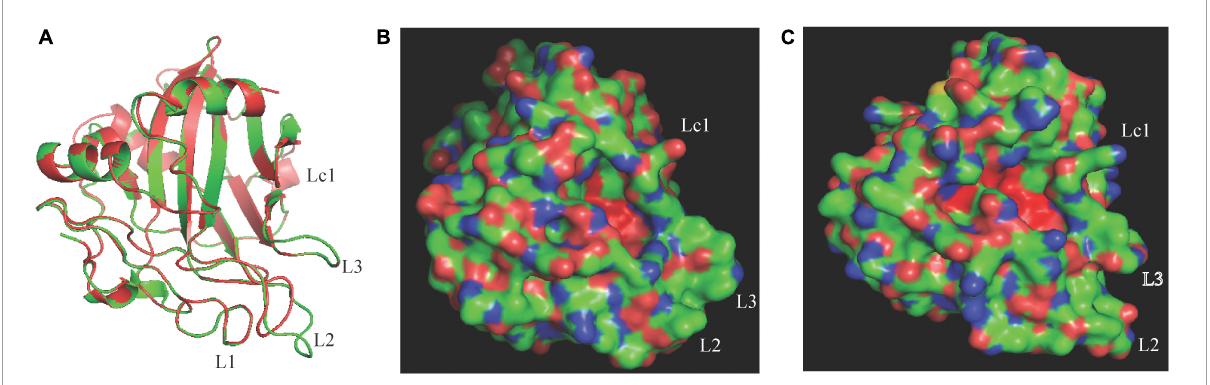
FIGURE4 Comparison of predicted protein structure features between the weakly toxic CaNLP5 and the strongly toxic CaNLP9. (A) Superposition of CaNLP5 (red) and CaNLP9 (green). (B,C) Structures of the predicted protein surfaces of CaNLP5 and CaNLP9.